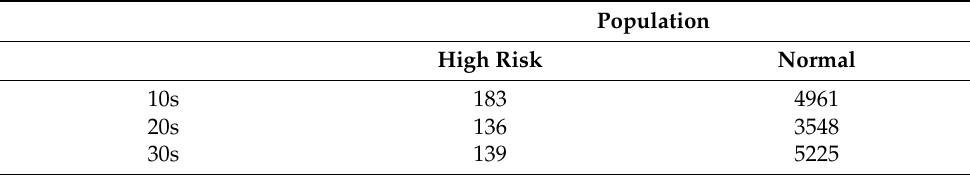
Table 2. The number of participants for each addiction type.